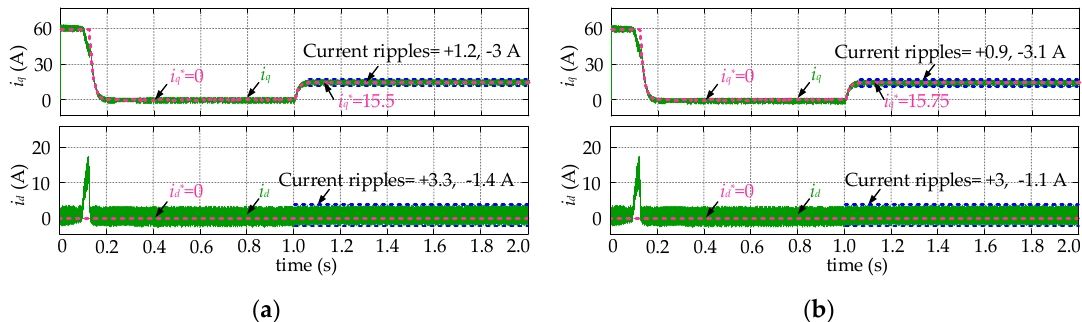
Figure 7. Current control performance of the proposed FCS-MPCC method under different resistance and inductance disturbances: ( a ) L 0 = 2 L , ∆ L = − L , R s0 = R s , ∆ R s = 0; ( b ) L 0 = L , ∆ L = 0, R s0 = 5 R s , and inductance disturbances: ( a ) L 0 =2 L , ∆ L =- L , R s0 = R s , ∆ R s =0; ( b ) L 0 = L , ∆ L =0, R s0 =5 R s , ∆ R s =-4 R s . ∆ R = − 4 R s s .